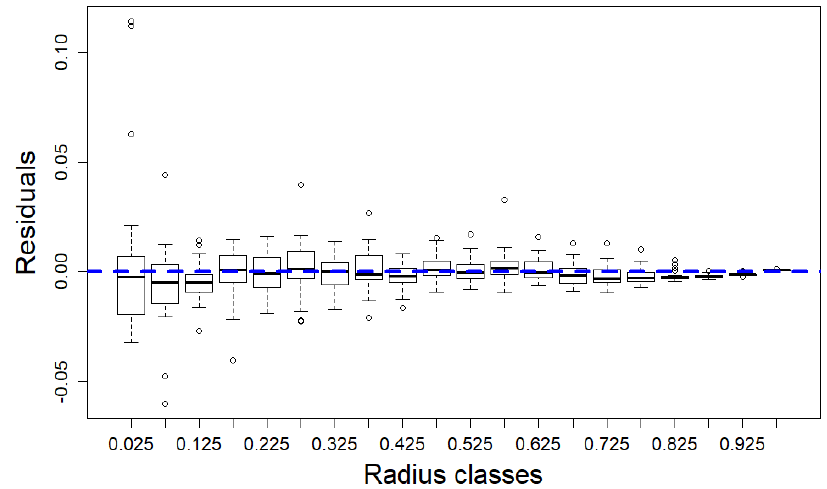
Figure 8. Residual variability of horizontal branch biomass distribution per relative crown radius ( rcr ) class, where the dashed blue line corresponds to zero. The width of the radius classes is 0.05, and the midpoints are indicated by ticks on the x -axis. The same 20 classes of rcr have been considered as for Figures 2, 7 and 9.